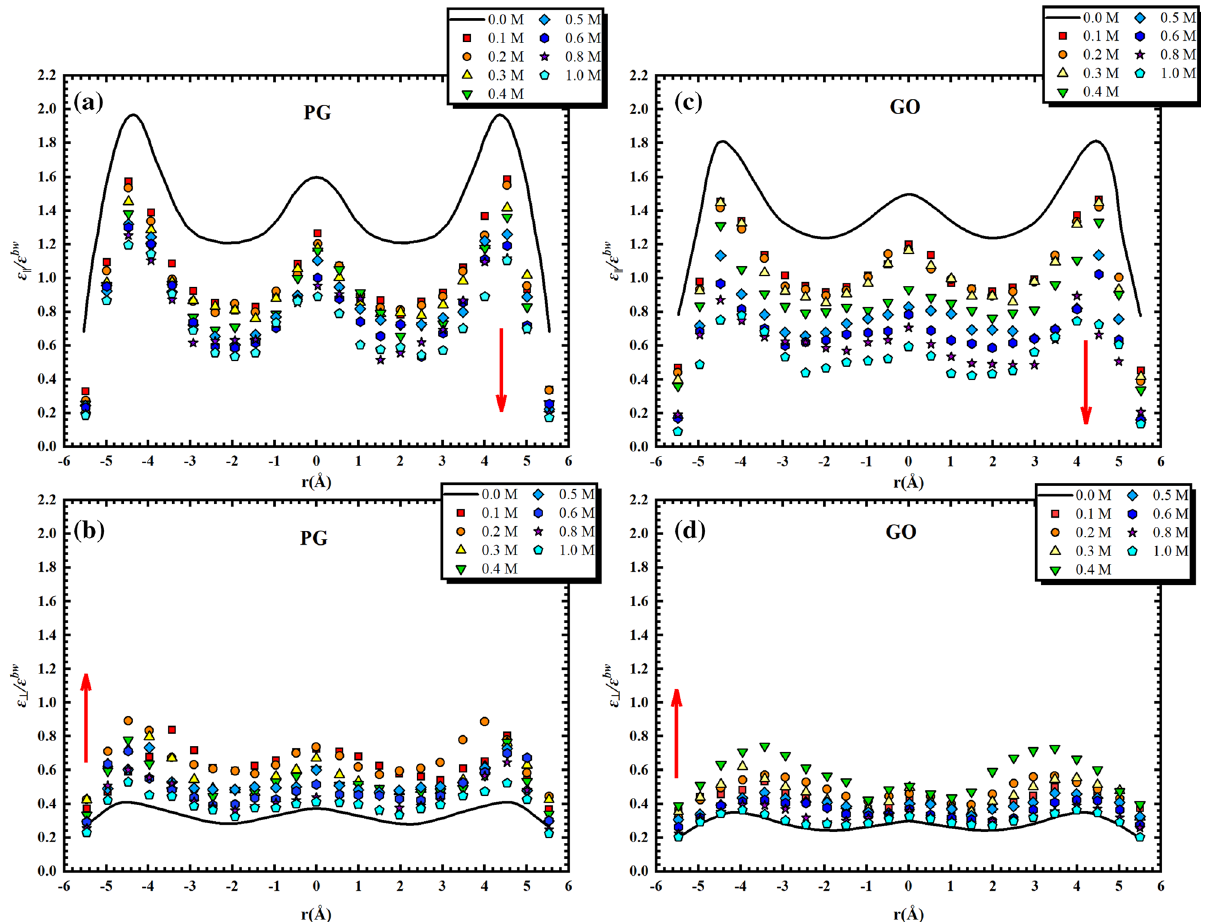
Figure 2. Ratio of out-of-plane ( ε ⊥ ) and in-plane ( ε (cid:31) ) dielectric components of various salt concentrations in both PG ( a , b ) and GO ( c , d ) channels to that of water in bulk phase ( ε bw ).